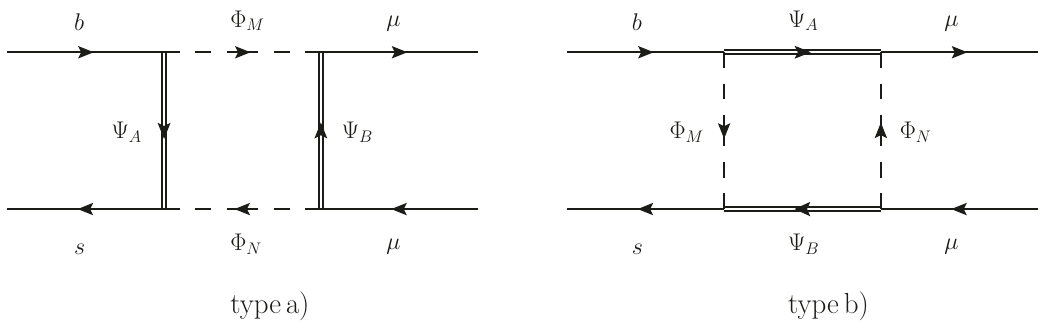
Figure 1 . Box diagrams contributing to b ! s(cid:22) + (cid:22) (cid:0) transitions. The diagram on the left is generated in models in which the fermions couples only to SM quarks or only to SM leptons, which corresponds to type a ). The diagram on the right refers to models with scalars connecting b to s and (cid:22) to (cid:22) , i.e. type b